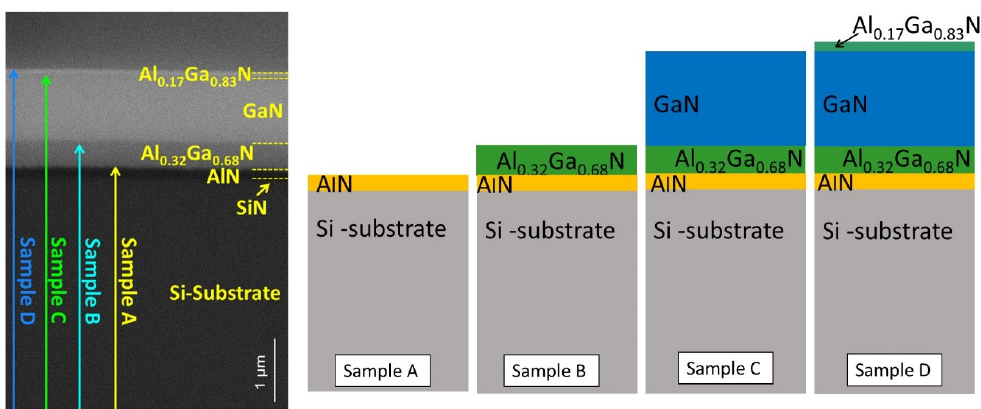
Figure 1. On the left-hand side, the SEM image of the cross-section of the AlGaN-GaN heterostructure (Sample D) is shown. The schematic of the studied AlGaN-GaN-based high-electron-mobility transistor (HEMT) structures is visualised on the right (Samples A–D).